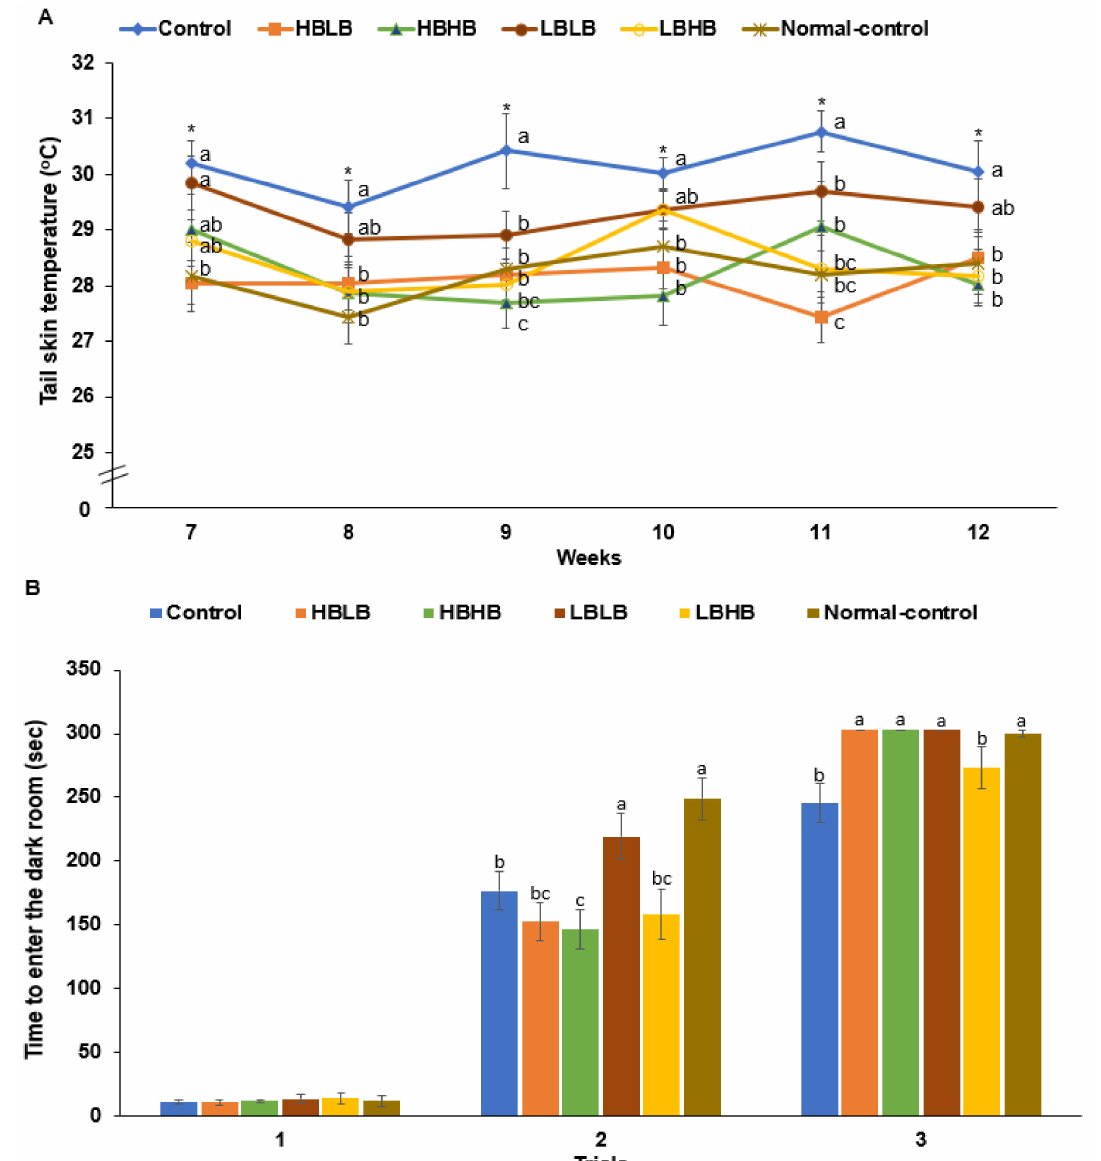
Figure 2. Tail skin temperature and passive avoidance test after ovariectomized rats. ( A ). Tail skin temperature during 7–12 weeks ( B ). Time to enter the darkroom. Dots or bars and error bars represent the means ± standard deviations ( n = 10). HBLB, the rats fed TMK with high contents of Bacillus spp. and high biogenic amines; HBHB, the rats fed TMK with high contents of Bacillus spp. and low biogenic amines; LBHB, the rats fed TMK with low contents of Bacillus spp. and high biogenic amines; LBLB, the rats fed TMK with low contents of Bacillus spp. and low biogenic amines. * Significantly different among the groups at p < 0.05. a–c Different letters on the bars indicated a significant difference among the groups by Tukey test at p <